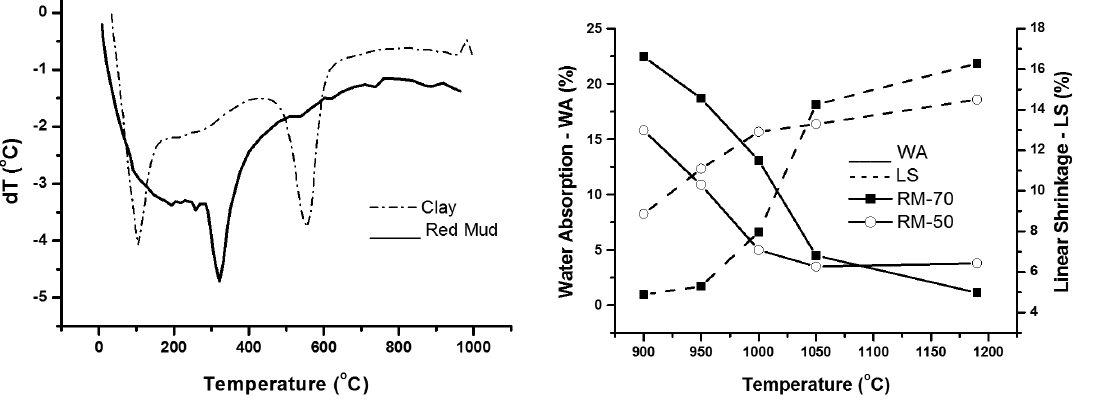
Figure 1. Differential thermal analysis (DTA) of red mud and clay.